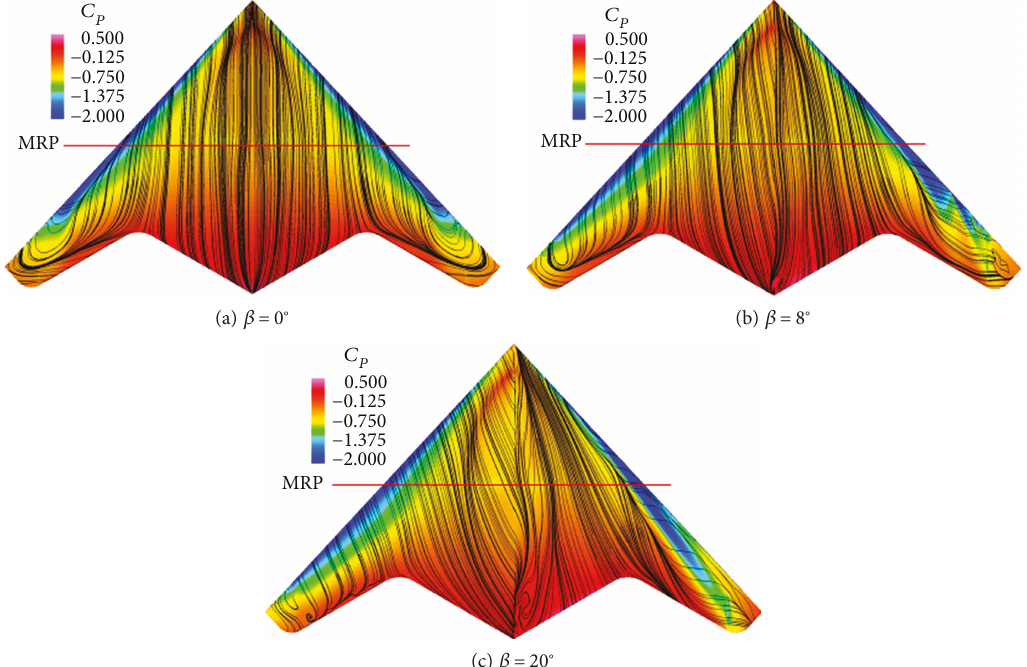
Figure 8: Skin friction lines and pressure coe ffi cient contours at angle of attack 12 °